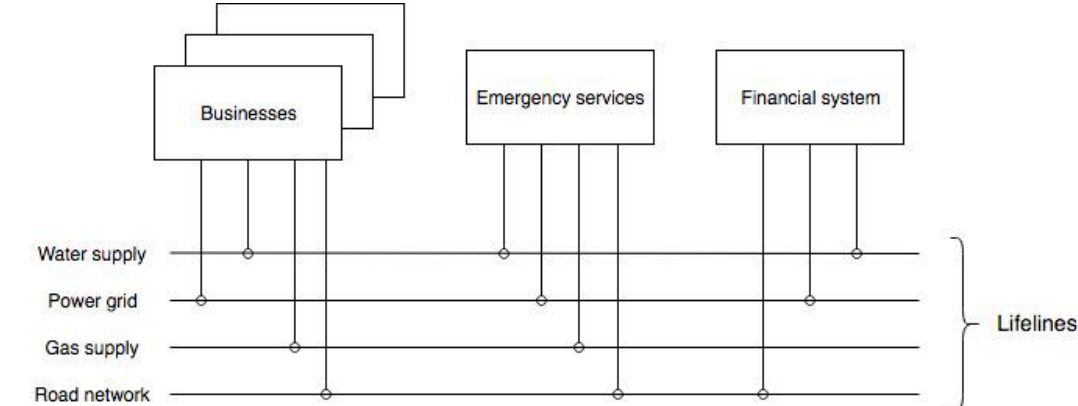
Figure 1. Conceptual model of infrastructure system-of-systems, where complexity is two-fold, i.e., within and between specific systems.